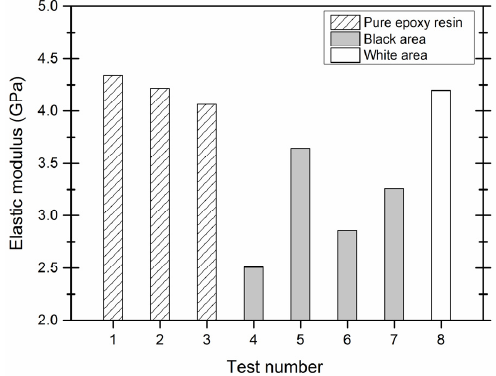
Figure 10. Elastic moduli of different areas in each specimen.